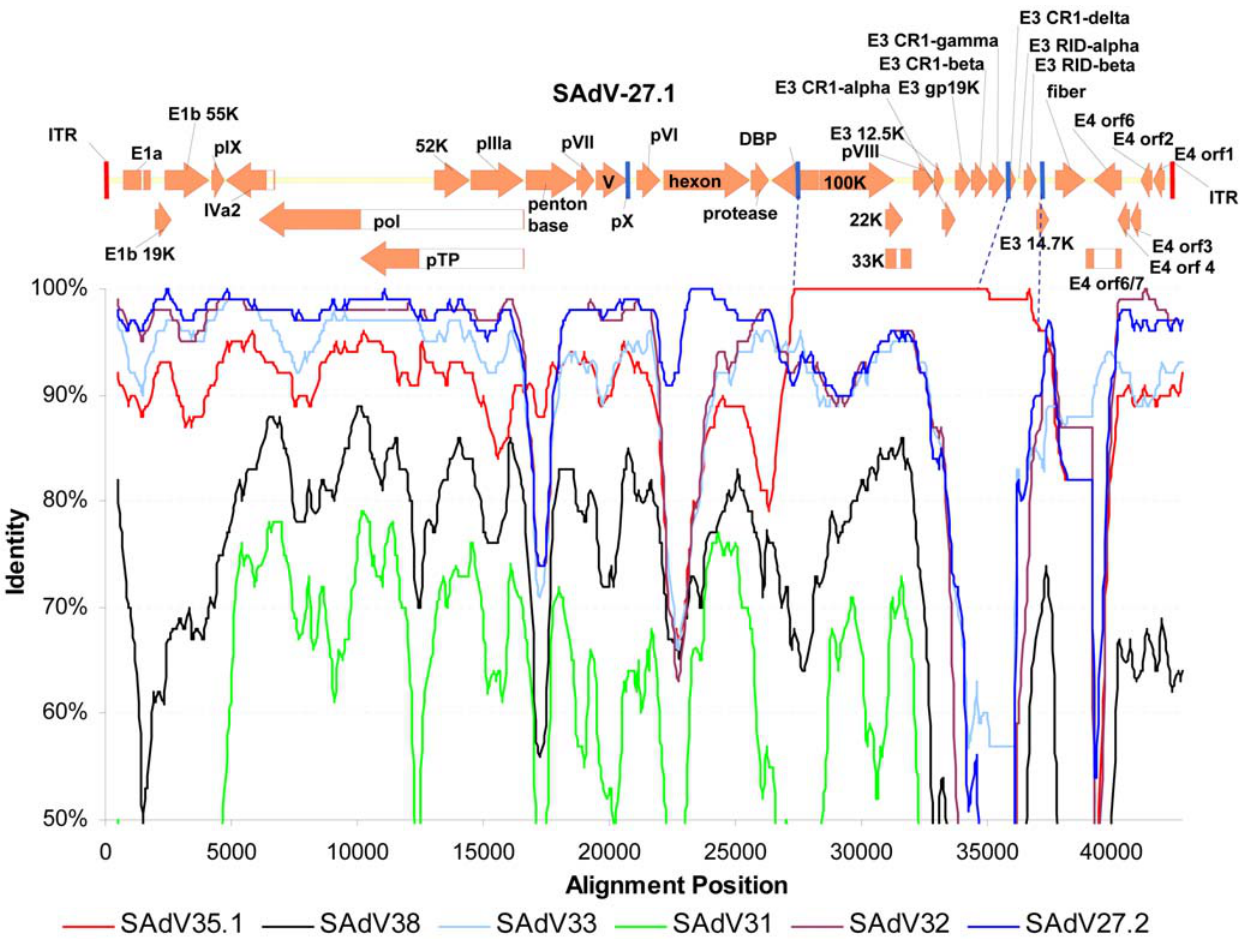
Figure 2. Evidence for intra-species B recombination within the New Iberia chimpanzee colony. A Simplot analysis of New Iberia species B adenoviral isolates aligned with a schematic annotated genomic structure of the SAdV-27.1 showing evidence of an incidence of recombination between viral isolates from the same compound. The analysis demonstrates homology on the left genomic end extending up to the DNA Binding Protein (DBP) open reading frame with various species B isolates from within one subspecies (represented by SAdV-32) from the New Iberia chimpanzee colony, followed by an 100K, 22K, 33K and partial E3 gene region of near complete identity to the structurally distinct New Iberia isolate SAdV-35.1 of a distinct subspecies within species B. To the right of this region of identity the homology transitions to the fiber region first to B isolate SAdV-33 and subsequently to SAdV-32 again. Further evidence is provided by SAdV-27.2, isolated from a gorilla in a different geographical location (Atlanta zoo). This genome is closely related to SAdV-27.1 and is almost identical in hexon but did not undergo the presumed recombination event between DBP and E3. The left and extreme right ends of the SADV-27.1 genome demonstrate close but not complete identity to SAdV-32 indicating a close relationship to the putative parental adenovirus of this event of homoplasy. The left junction of the recombination event is a clearly defined junction centrally in the DNA binding protein as indicated by the dotted blue line. The right end junction was less well-defined due to a region of lack of complete identity in the fiber-proximal part of the coding region of the E3 gene family. This region is indicated by the dotted blue lines in the sequence. The more distantly related species B isolate SAdV-35, species C isolate SAdV-31 and species E isolate SAdV-38 (all isolated from the New Iberia chimpanzee colony) are provided in the analysis as